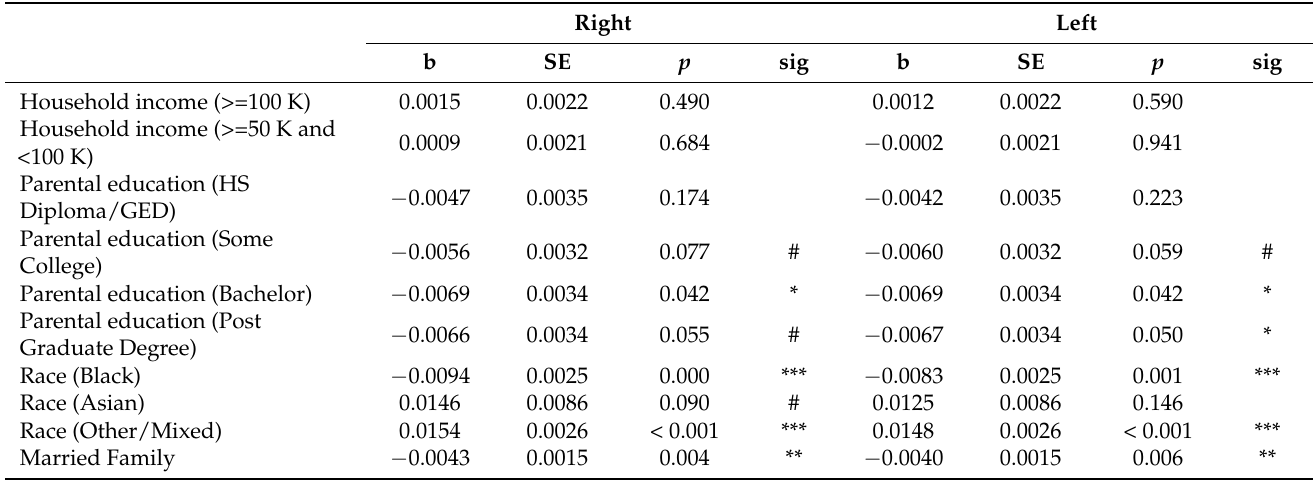
3.5. Household Income and Right and Left Cerebellum Cortex Fractional Anisotropy Table 5 shows the results of regression models in the total sample with household income as the predictor and right and left cerebellum cortex fractional anisotropy as the outcome. In the pooled sample, we found significant interactions between race and household income on the right and left cerebellum cortex fractional anisotropy. Table 5. Regressions on the association between household income with right and left cerebellum cortex fractional